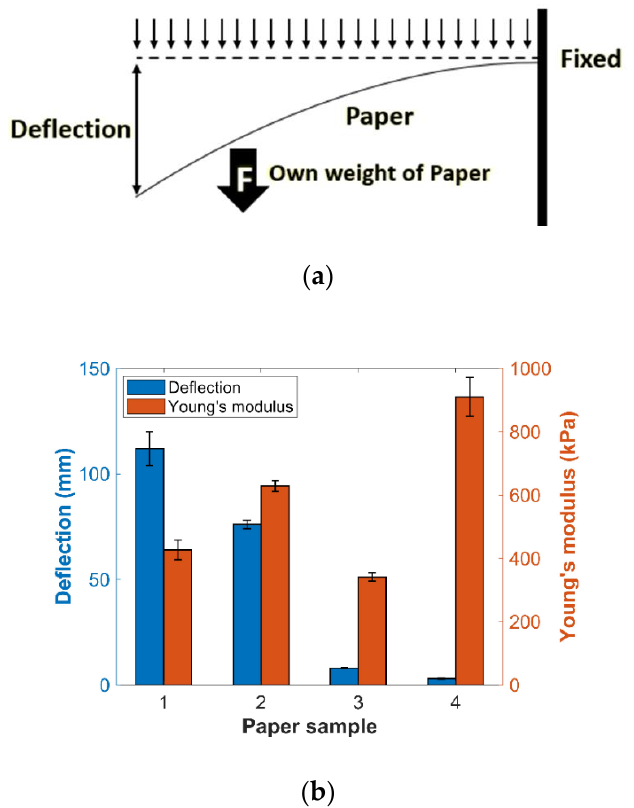
Figure 6. Characterization of Young’s modulus using deflection measurement. ( a ) Schematic images of paper deflection test. ( b ) Deflection measurement value and calculated value of Young’s modulus according to the paper